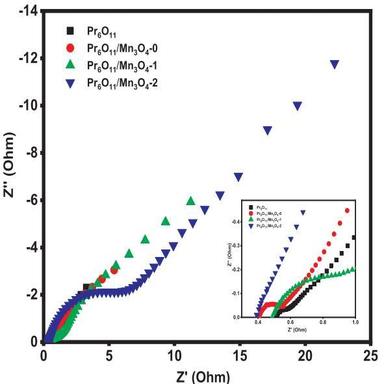
Nyquist plot of Pr6O11, Pr6O11/Mn3O4-0, Pr6O11/Mn3O4-1 and Pr6O11/ Mn3O4-2 based electrode.